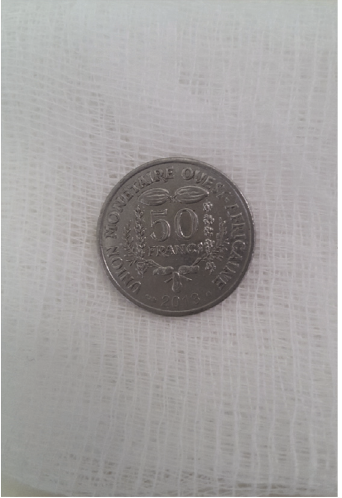
Figure 3: The removed